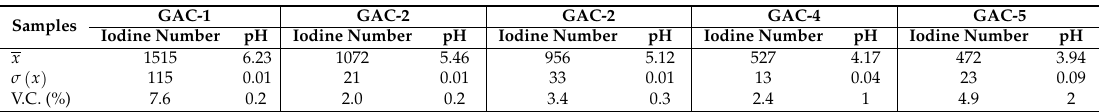
Table 2. Iodine number and contact pH of the GAC samples.